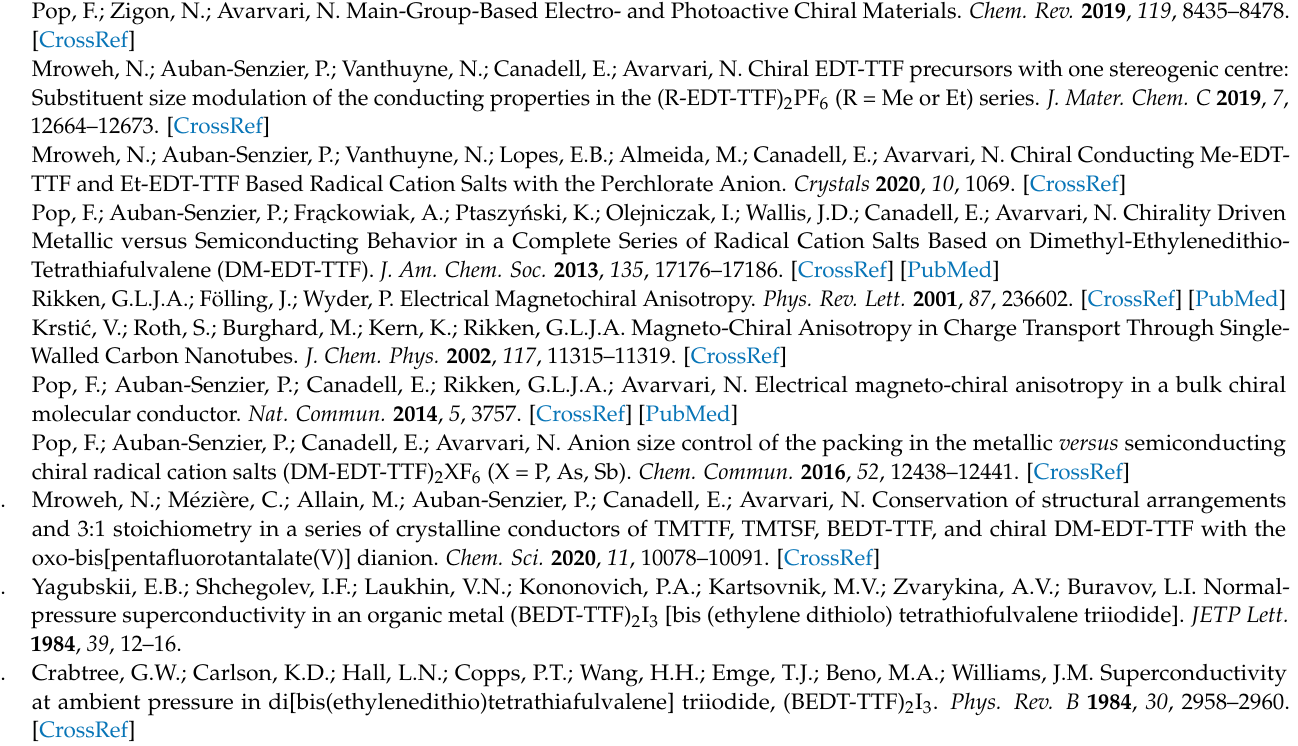
Table S4: Crystal Data and Structure Refinement for [( S )- 1 ]AsF 6 · C 4 H 8 O and [( R )- 1 ]AsF 6 · C 4 H 8 O; Table S5: C–H ··· F hydrogen bonding distances (Å) and angles in [( S )- 1 ]AsF 6 · C 4 H 8 O; Table S6: C– H ··· F hydrogen bonding distances (Å) and angles in [( R )- 1 ]AsF 6 · C 4 H 8 O; Table S7: Crystal Data and Structure Refinement for [( rac )- 1 ]I 3 , [( S )- 1 ]I 3 and [( R )- 1 ]I 3 ; Table S8: Selected C = C and C–S internal bond lengths for [( S )- 1 ]I 3 ; Table S9: Crystal Data and Structure Refinement for [( rac )- 2 ]I 3 , [( S,S )- 2 ]I 3 and [( R,R )- 2 ]I 3 ; Table S10: Selected C = C and C–S internal bond lengths for ( 2 )I 3 ; Table S11: Crystal Data and Structure Refinement for ( meso )- 2 , [( meso )- 2 ]ClO 4 , [( meso )- 2 ]PF 6 and [( meso )- 2 ]ReO 4 ; Table S12: Selected C = C and C–S internal bond lengths for ( meso )- 2 , [( meso )- 2 ]ClO 4 , [( meso )- 2 ]PF 6 and [( meso )- 2 ]ReO 4